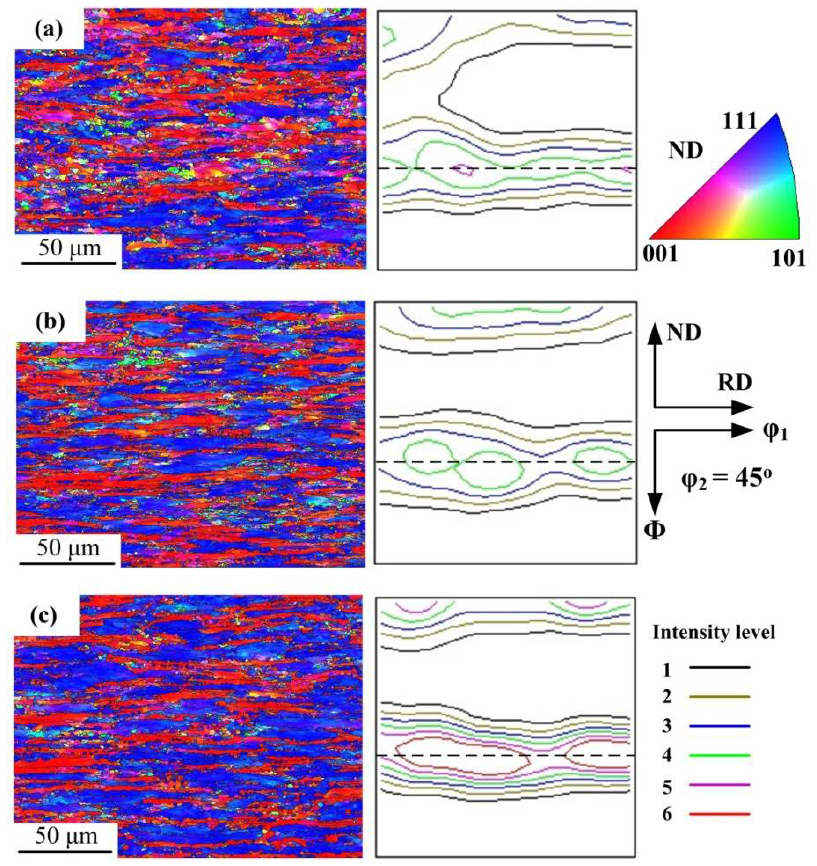
Figure 11. Grain orientation map of ( a ) 650 °C, 0.1 s −1 ( b ) 700 °C, 0.1 s −1 ( c ) 700 °C, 1 s −1 .